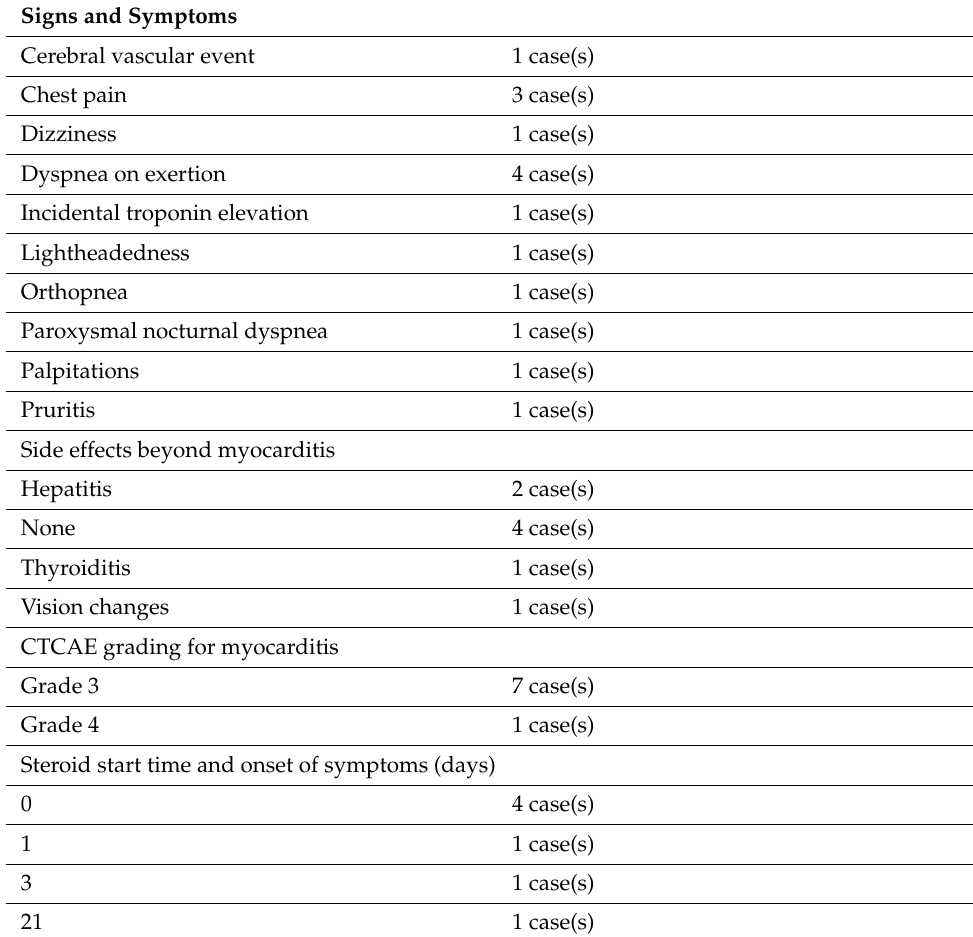
Table 2. Immune checkpoint inhibitor (ICI)-associated myocarditis clinical presentation, cardiac biomarkers, treatment regimen and major adverse cardiac events